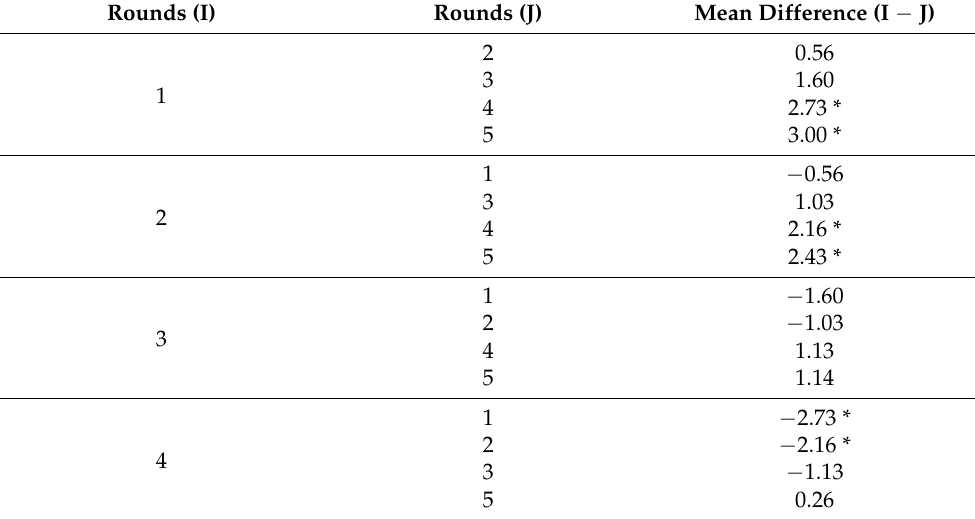
Table 3. Results of post-analysis analyzed by round when looking at the difference in the number of collisions per route; there was a significant difference in the fourth and fifth rounds compared to the